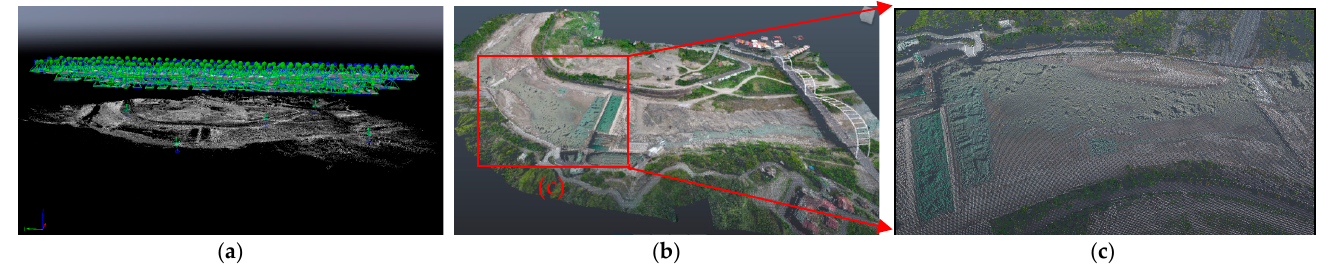
Figure 9. The point cloud generated by Pix4D software. ( a ) Generated point cloud based on UAV aerial pictures, ( b ) final point cloud picture, and ( c ) the zoom-in view of point cloud of the study area. Table 1. The information from the quality report of each UAV flight missions.